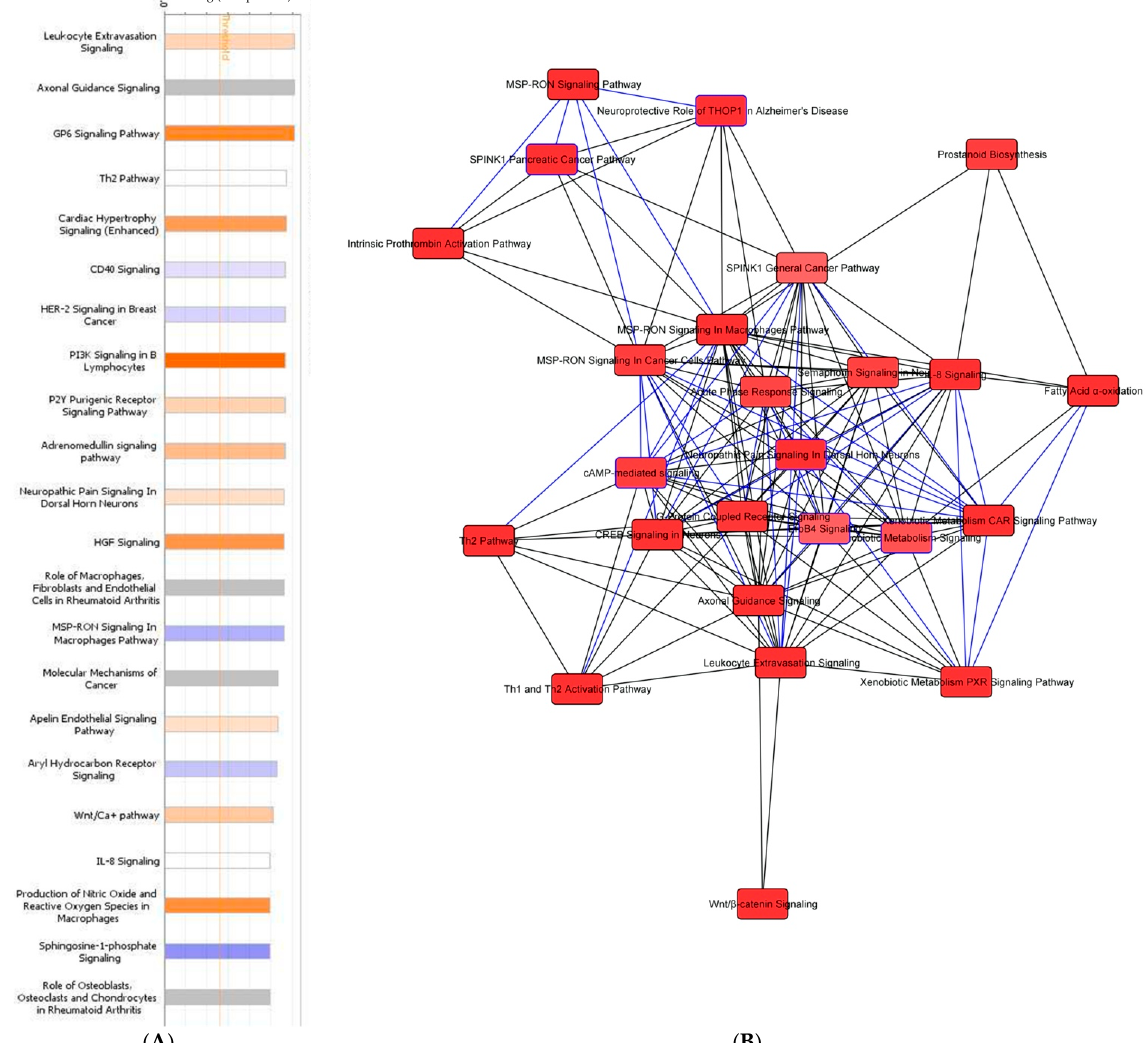
Figure 6. Differential expression analysis of carboplatin-resistant TO versus carboplatin-sensitive subjects. ( A ) Pathway analysis of genes differentially expressed between carboplatin-resistant and carboplatin-sensitive TOs. ( B ) Network analysis of the pathways differentially expressed between carboplatin-resistant and carboplatin-sensitive